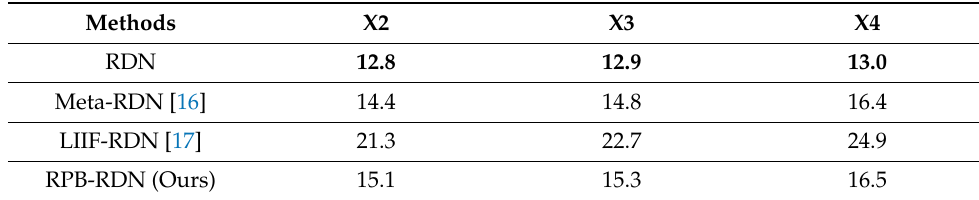
Table 3. The running time in B100 of various SR approaches (ms). The best performance is highlighted in the bold format.